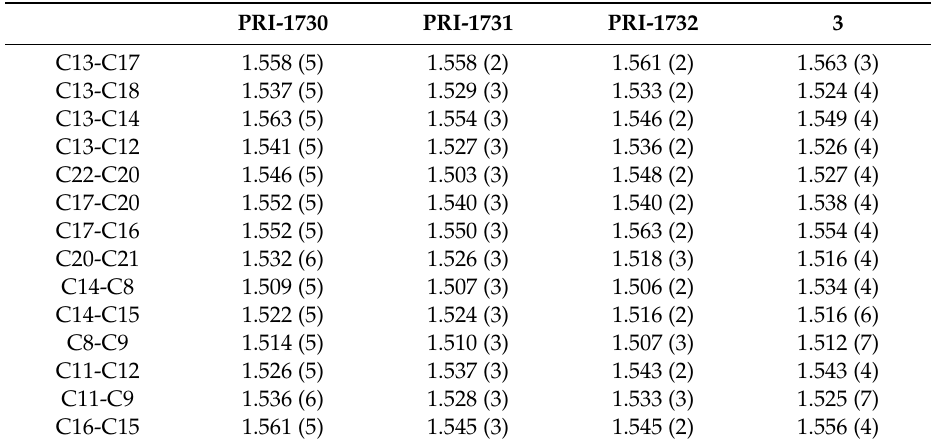
Table 2. Geometry analysis of CD-ring system of analogues of vitamin D and corresponding bonds from 3 . Bond lengths given in